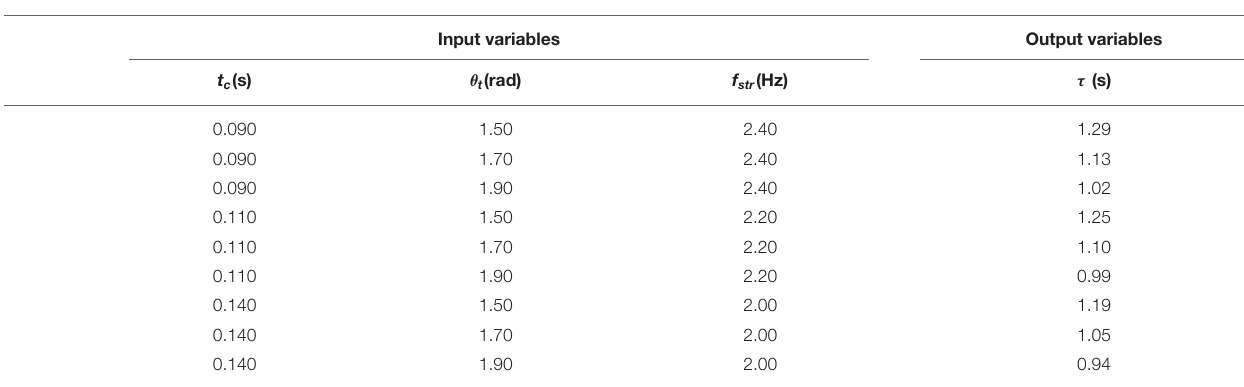
TABLE 1 | Performance calculations using the theoretical framework. Evaluation of Equation 8 across a range of fundamental gait